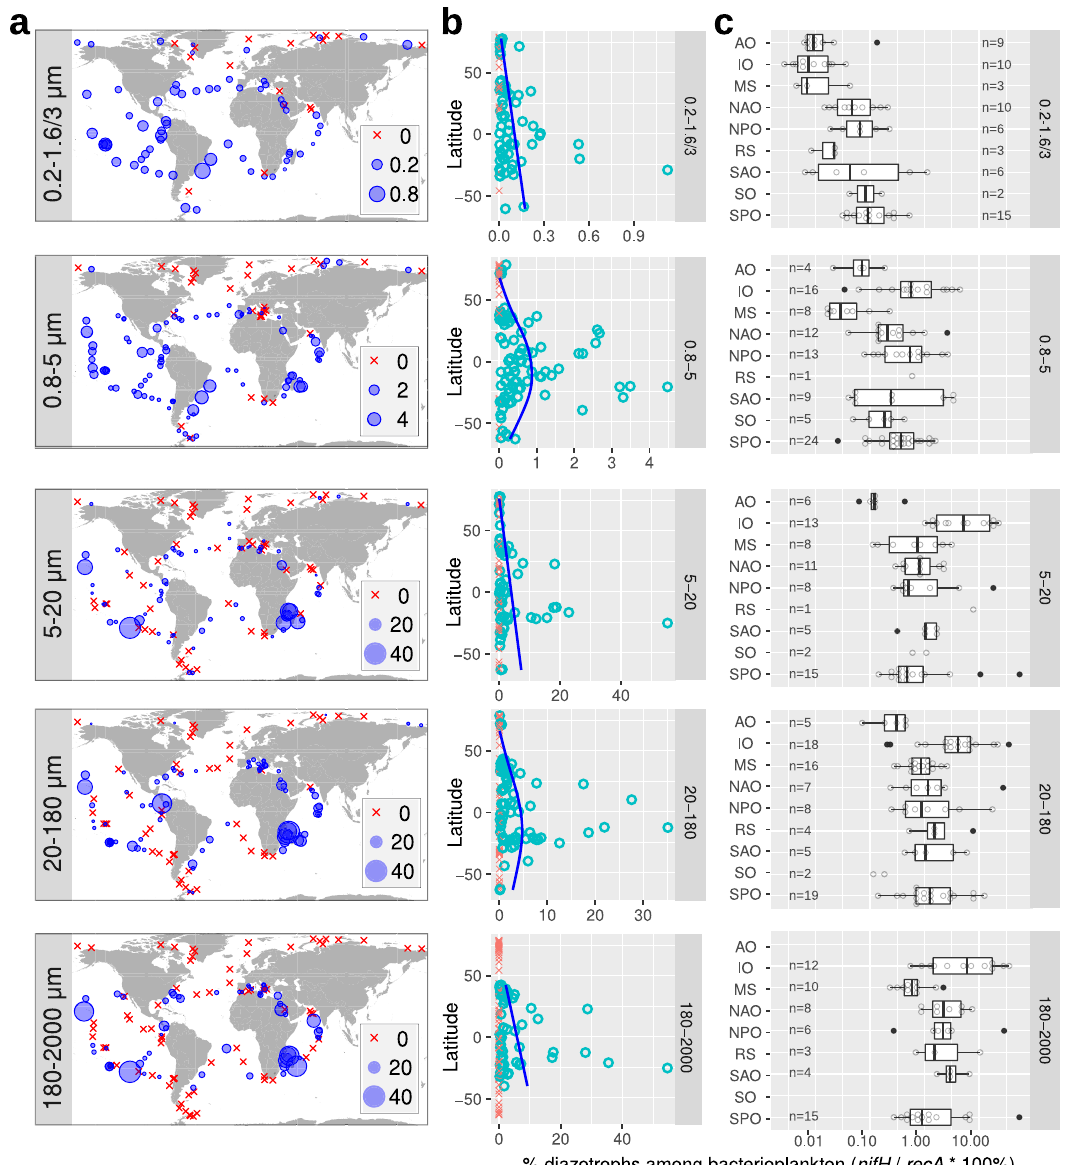
Fig. 4 Biogeography of diazotrophs in surface waters using metagenomes obtained from different size-fractionated samples. The percentage of diazotrophs in the bacterioplankton community was estimated by the ratio of metagenomic read abundance between the marker genes nifH and recA . a Biogeography. The bubble size varies according to the percentage of diazotrophs, while red crosses indicate absence (i.e., no detection of nifH reads). b Latitudinal abundance gradient. The blue lines correspond to generalized additive model smoothings. c Ocean distribution. MS Mediterranean Sea, IO Indian Ocean, SAO South Atlantic Ocean, SO Southern Ocean, SPO South Paci fi c Ocean, NPO North Paci fi c Ocean, NAO North Atlantic Ocean, AO Arctic Ocean. Boxplots depict the 25 – 75% quantile range of the dataset without zeros (the corresponding biologically independent seawater samples are indicated in the plot), with the center line depicting the median (50% quantile); whiskers encompass data points within 1.5× the interquartile range. Source data are provided as a Source data fi